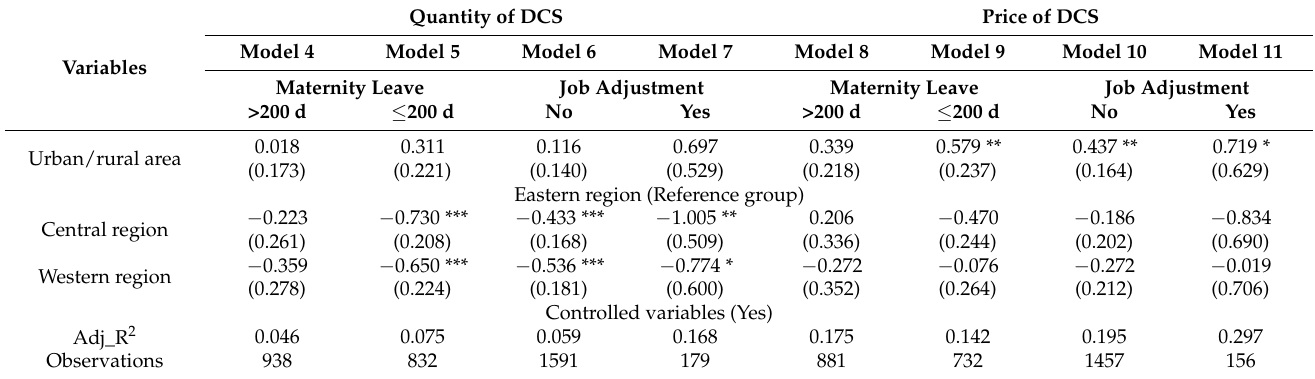
Table 3. The moderating effect of current status of